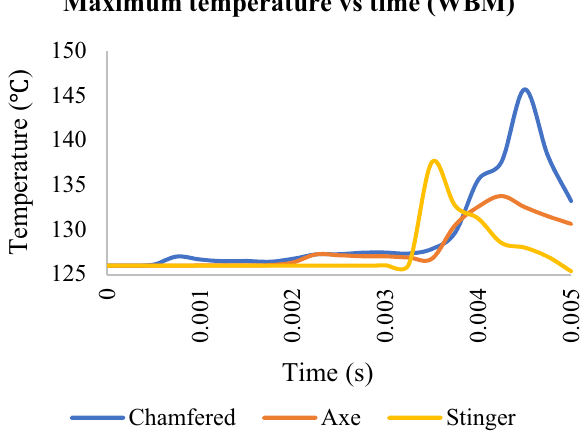
Fig. 17 Maximum temperature versus time with synthetic-based mud